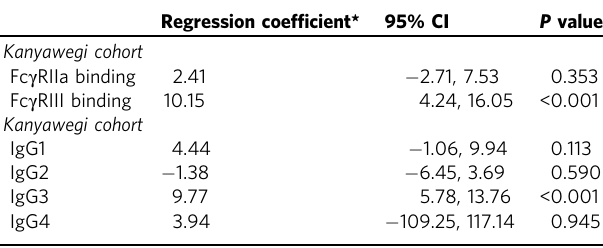
Table 1 Multivariate analysis of the association of opsonic phagocytosis of CSP-coated beads by neutrophils with Fc γ RIIa, Fc γ RIII, IgG subclasses and in the Kenyan adult cohort.